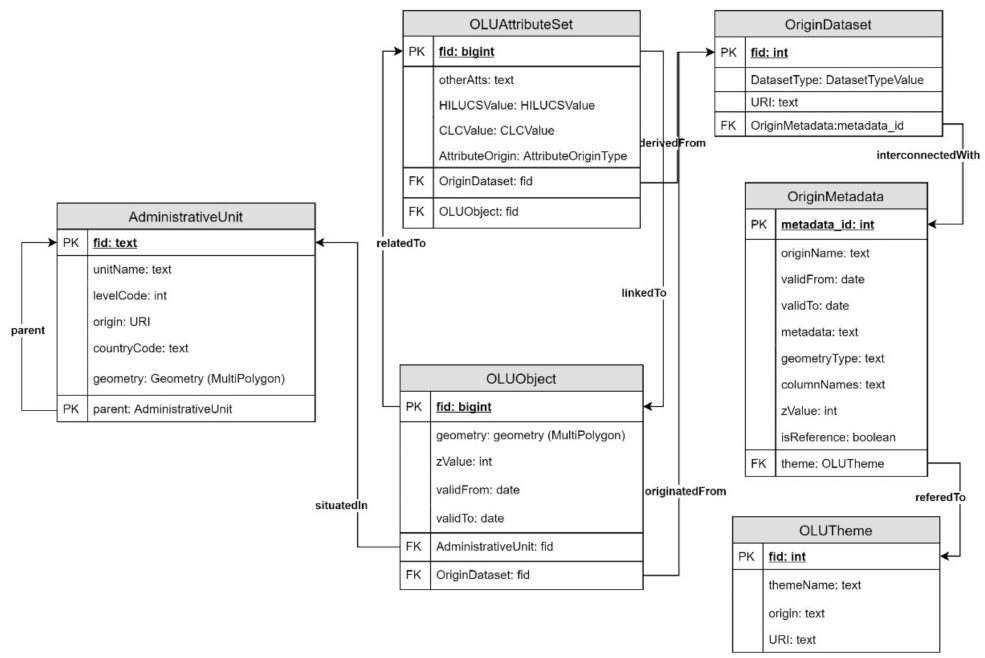
Figure 2. Diagram of OLU data model version